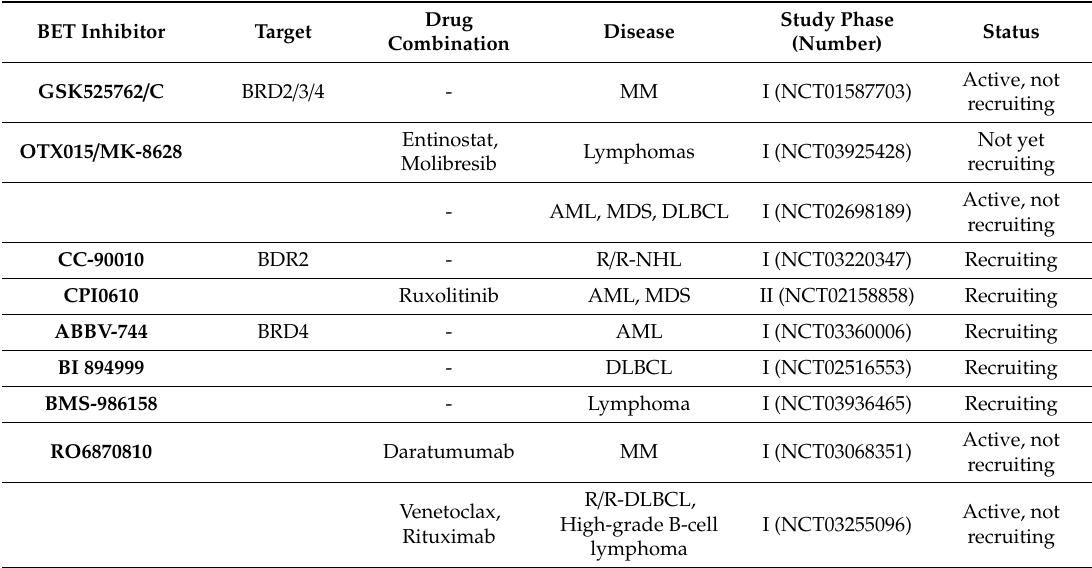
Table 1. Ongoing clinical trials evaluating BET inhibitors in hematological